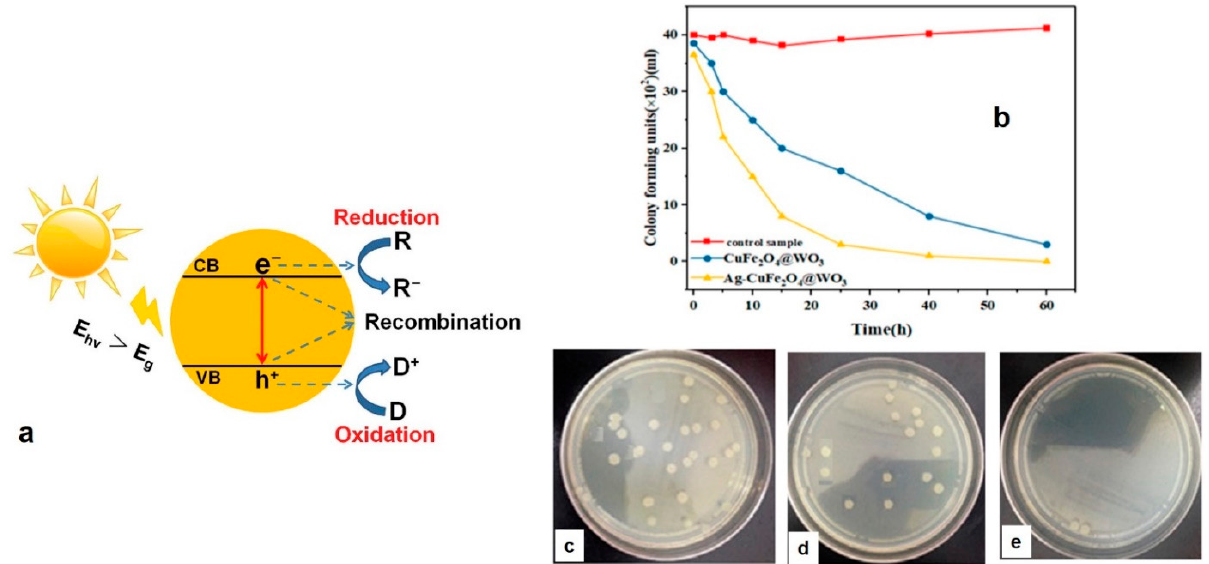
Figure 5. ( a ) Schematic illustrates the solar light driven photocatalysis ( E hv and E g are the solar light photon energy and band gap energy, respectively, and, CB and VB are the conduction and valence band, respectively. R and D are the electron acceptor and electron donor, respectively. Reproduced with permission [68], Copyright 2017, Elsevier. ( b ) The Ag-CuFe 2 O 4 @WO 3 nanohybrid nanoparticles kill E. coli within the course of a 60 h incubation period upon exposure to UV light. The density of the bacteria colonies imaged in the absence of the nanohybrid nanoparticles ( c ), and in the presence of CuFe 2 O 4 @WO 3 ( d ) and Ag-CuFe 2 O 4 @WO 3 nanoparticles ( e ). Reproduced with permission [67]